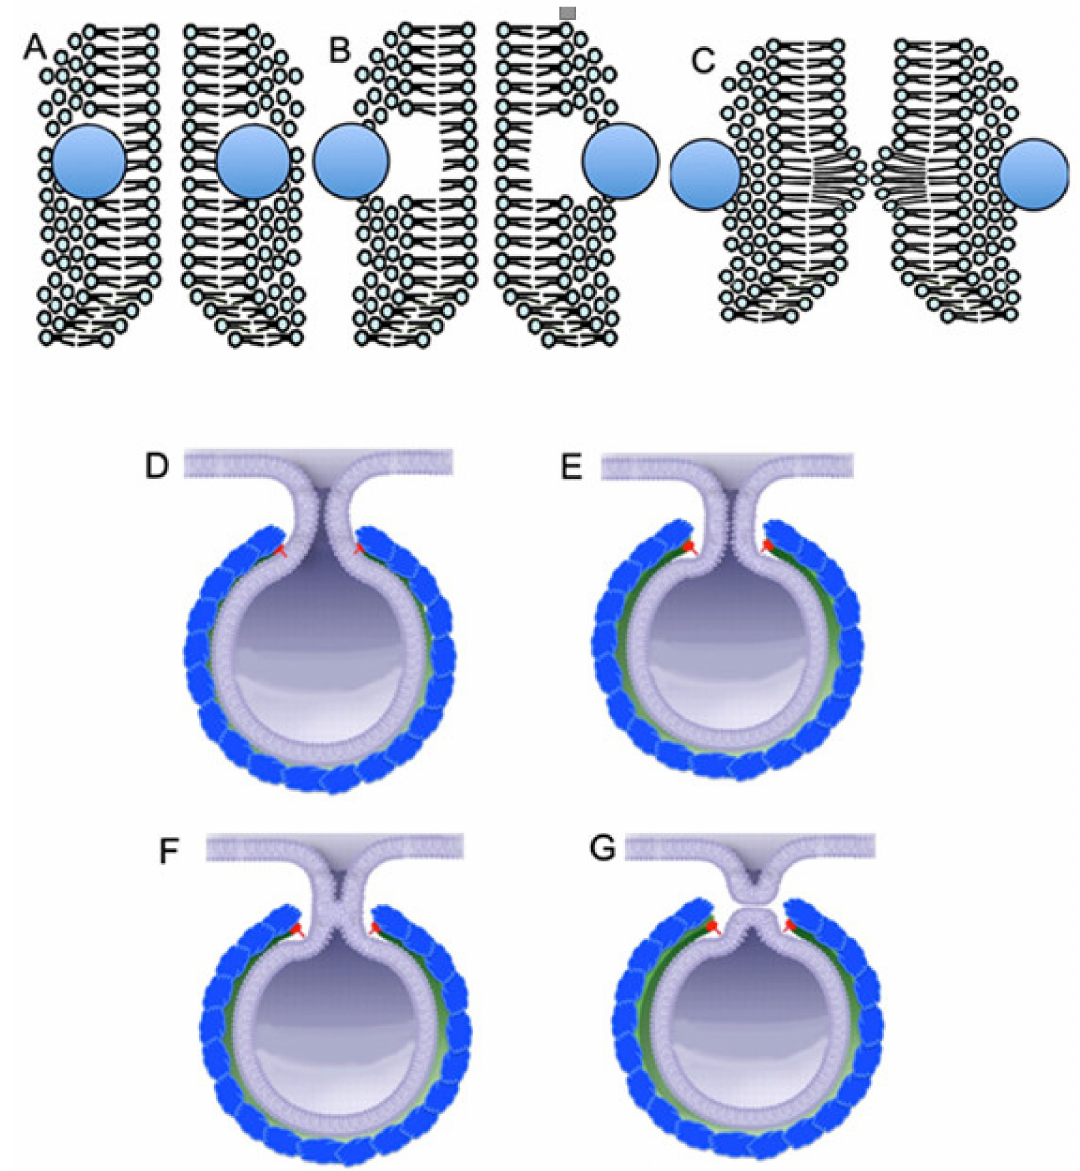
Figure 3. The sudden elimination of coat proteins from the cytosolic leaflet of the lipid membrane can induce destabilization of a thin tubule, due to formation of protrusion of the luminal leaflet ( A , B ). Such a quick event induces formation of the excess of the luminal leaflet, and generation of the circular fold on the inner surface of the tube. This fold induces periplasmic fusion and fission of the tube at this site ( C ). ( D – G ) Possible model of vesicle fission. ( D – G ) Consecutive stages of the fission process. The coat is attached to the neck of the bud ( D ). The thinning of the bud neck induces detachment of red protein from the cytosolic leaflet ( E ). This induces periplasmic fusion and fission of the tube at this site ( F , G